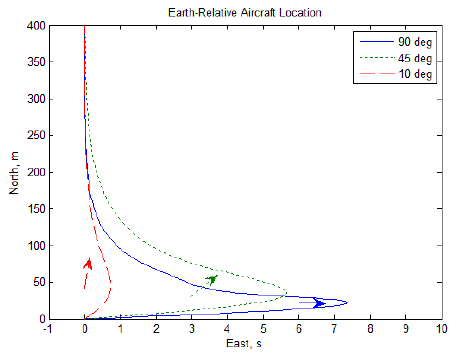
Figure 12: Wind velocity Symbol Meaning